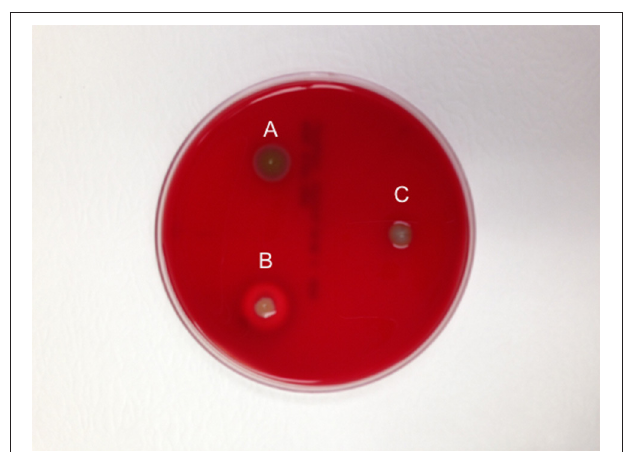
FIGURE 4 | Demonstration of the hemolytic activity in F. spartansii . The hemolytic activity on sheep blood agar plate was observed after